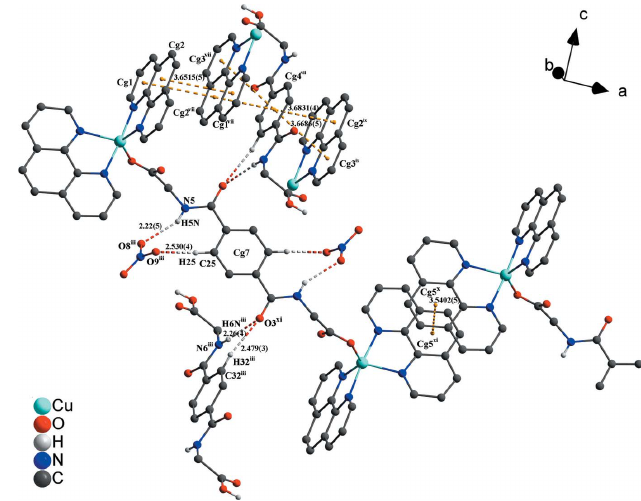
Figure 3 In the crystal packing, different non-covalent interactions such as C— H (cid:2)(cid:2)(cid:2) O and N—H (cid:2)(cid:2)(cid:2) O contacts and (cid:2) – (cid:2) stacking interactions between the aromatic moieties are present. C—H (cid:2)(cid:2)(cid:2) O and N—H (cid:2)(cid:2)(cid:2) O interactions are indicated by red–white dashed lines and (cid:2) – (cid:2) stacking by dark-yellow dashed lines. The hydrogen atoms not involved in interactions have been omitted for clarity. Distances are given in A˚ . [Symmetry codes: (iii) (cid:4) x + 1, (cid:4) y + 1, (cid:4) z + 1; (vii) (cid:4) x + 1, (cid:4) y , (cid:4) z + 2; (viii) x + 1, y (cid:4) 1, z ; (ix) x + 1, y , z ; (x) x + 2, y (cid:4) 1, z ; (xi) (cid:4) x + 2, (cid:4) y , (cid:4) z + 1.]